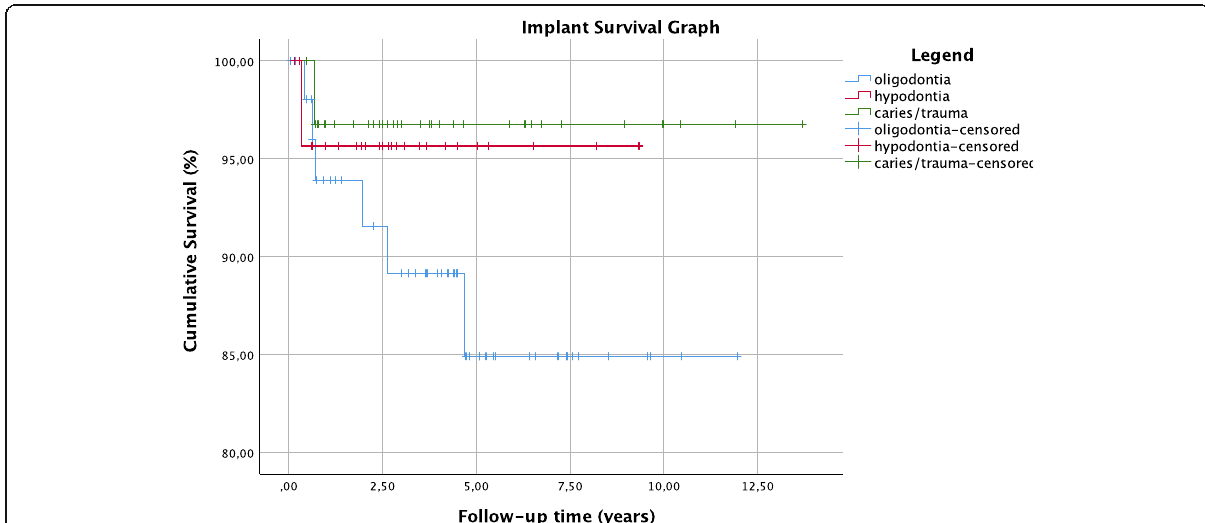
Fig. 2 Presentation of the implant survival function. Footnote: the non-congenital tooth loss group of patients showed a cumulative implant survival rate of 96.9% (mean survival = 13.27 years; 95% CI 12.46, 14.08 years), the hypodontia group showed a cumulative implant survival rate of